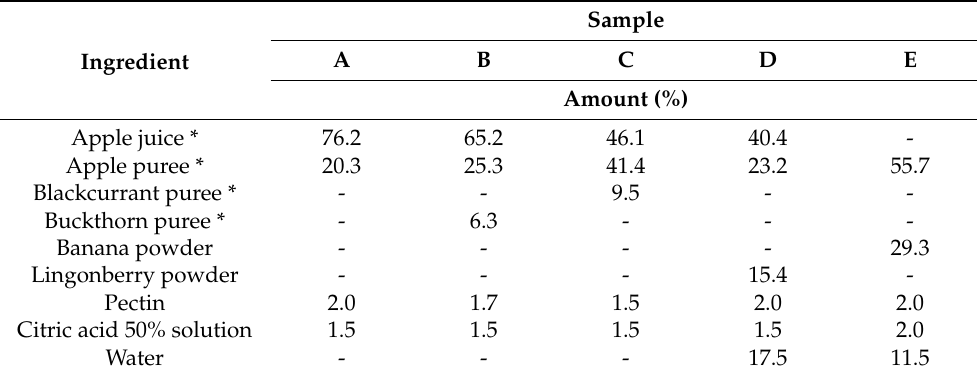
Table 3. Pectin gel tablets’